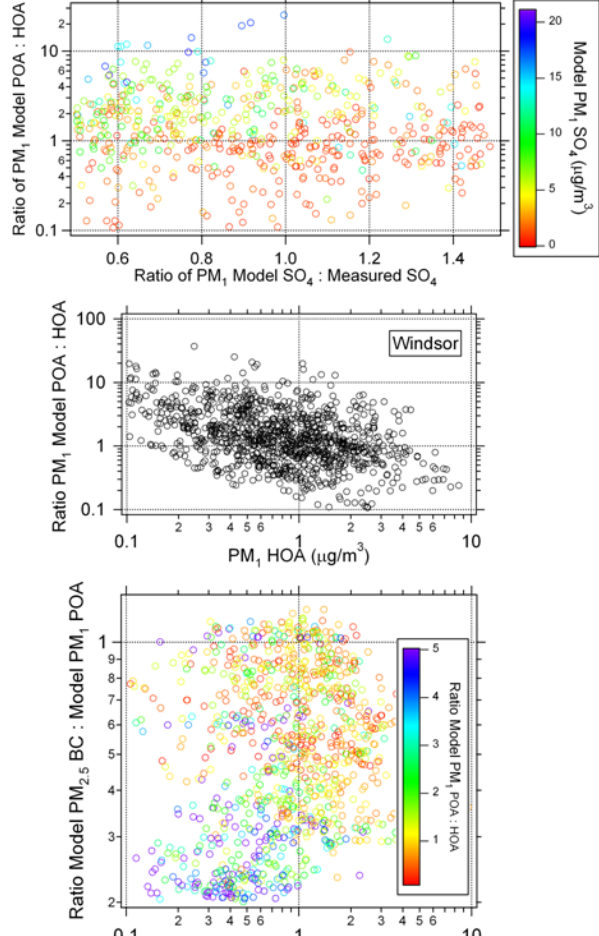
Fig. 5. Scatterplots for Windsor site of (a) ratio of PM 1 model POA to HOA vs. ratio of PM 1 model SO 4 to measured SO 4 , colour-coded with model SO 4 , (b) ratio of PM 1 model POA to HOA vs. HOA, and (c) ratio of PM 2 . 5 model BC to model POA vs. ratio of mea- sured PM 2 . 5 BC to HOA, colour-coded with ratio of model POA to HOA (yellow is unbiased, red is HOA underprediction, and blue is HOA overprediction). Data plotted for period 29 June to 11 July